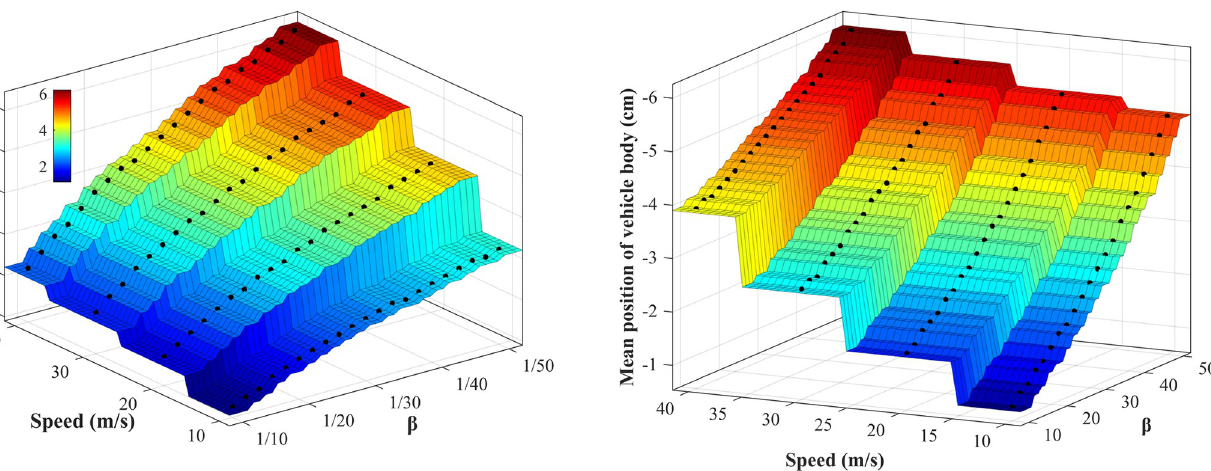
Fig 10. Vehicle body’s mean position with different speeds and β . (A) Vehicle body raises; (B) Vehicle body drops.